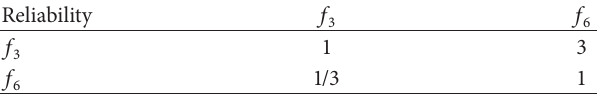
Table 5: Judgment matrix for the reliability.